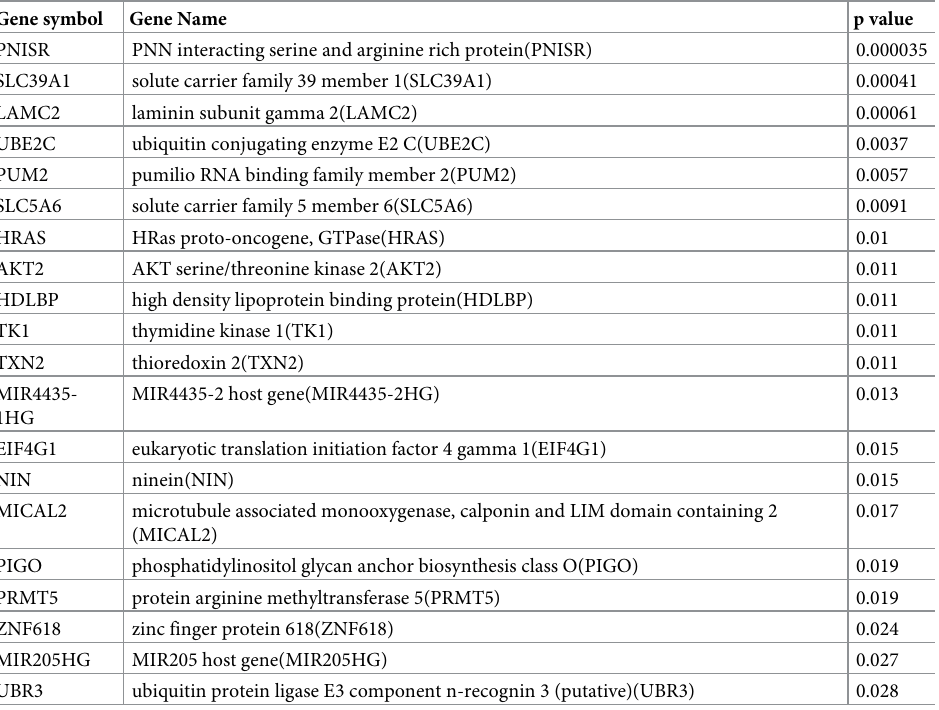
Table 2. The list of top 20 significant genes after junction analysis of the CPSF1 knockdown